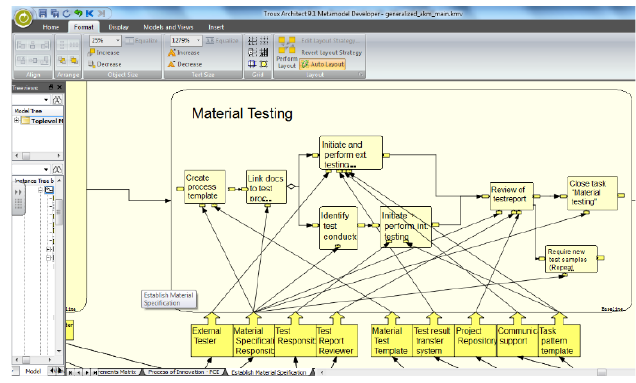
Fig. 4. Excerpt from an enterprise model (i.e., screenshot from a modelling tool) showing the cooperation between two network partners in material testing.